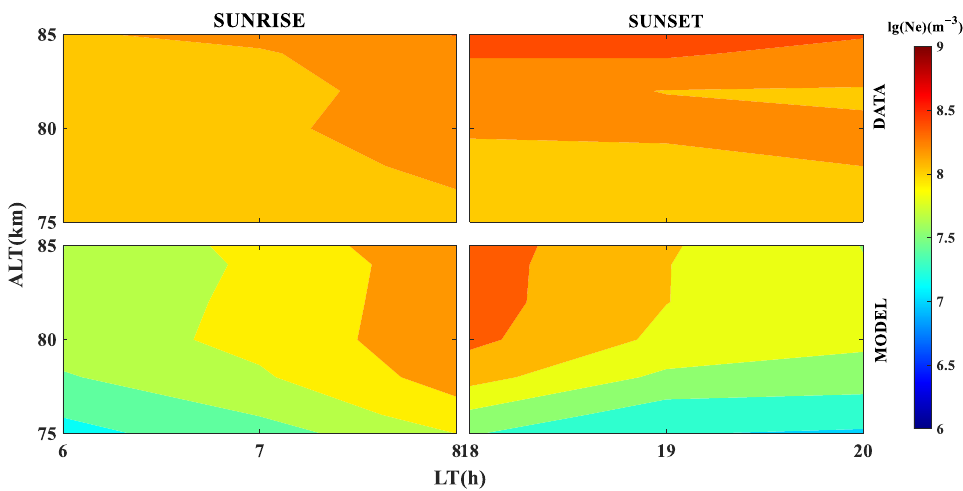
Figure 11. Comparison of the asymmetry of the measured electron densities with model results for sunrise (left) and sunset (right) at 75 – 85 km altitude.